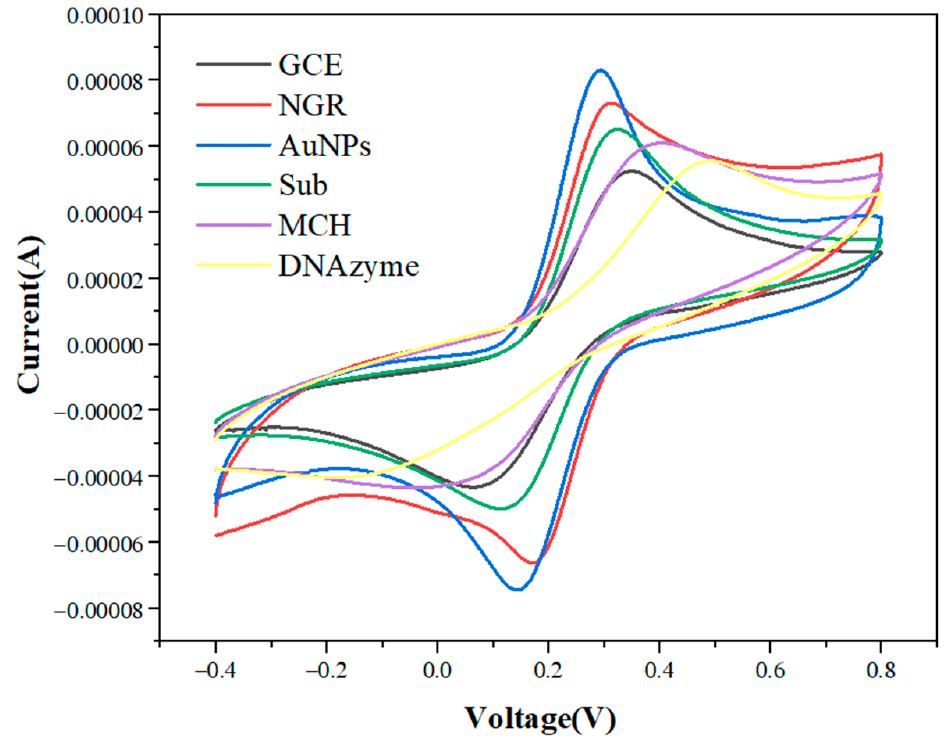
Figure 4. Cyclic voltammetry curves of GCE modified with NGR, AuNPs, Sub, MCH, and DNAzyme in 5.0 mmol/L [Fe(CN) 6 ] 4 − /3 − and 0.1 mol/L KCl at 50 mV/s scanning rate.